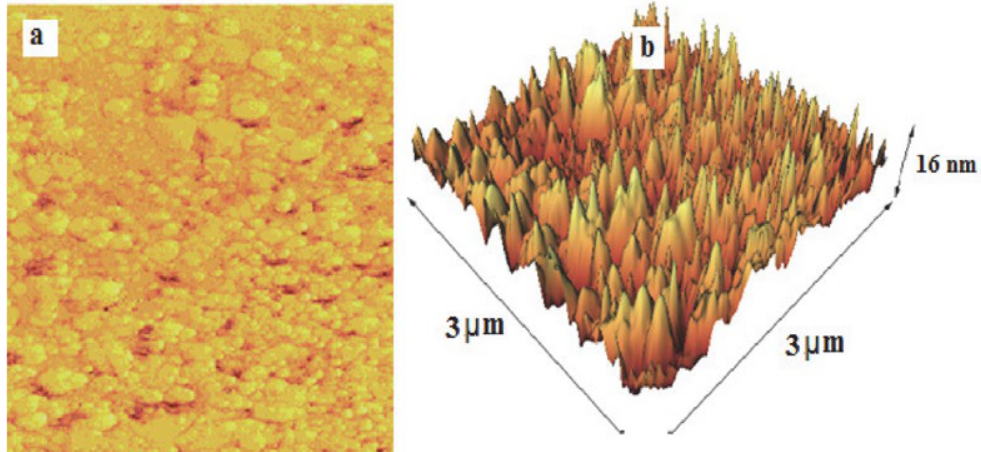
Figure 6. ( a) AFM image and (b) height profile of Fe